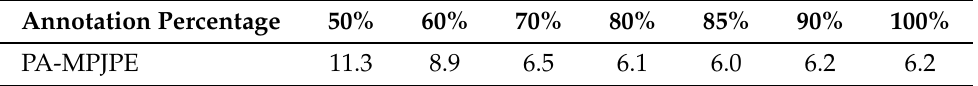
Table 5. Experiments of controlling the partial annotation percentage from 50% to full annotation.